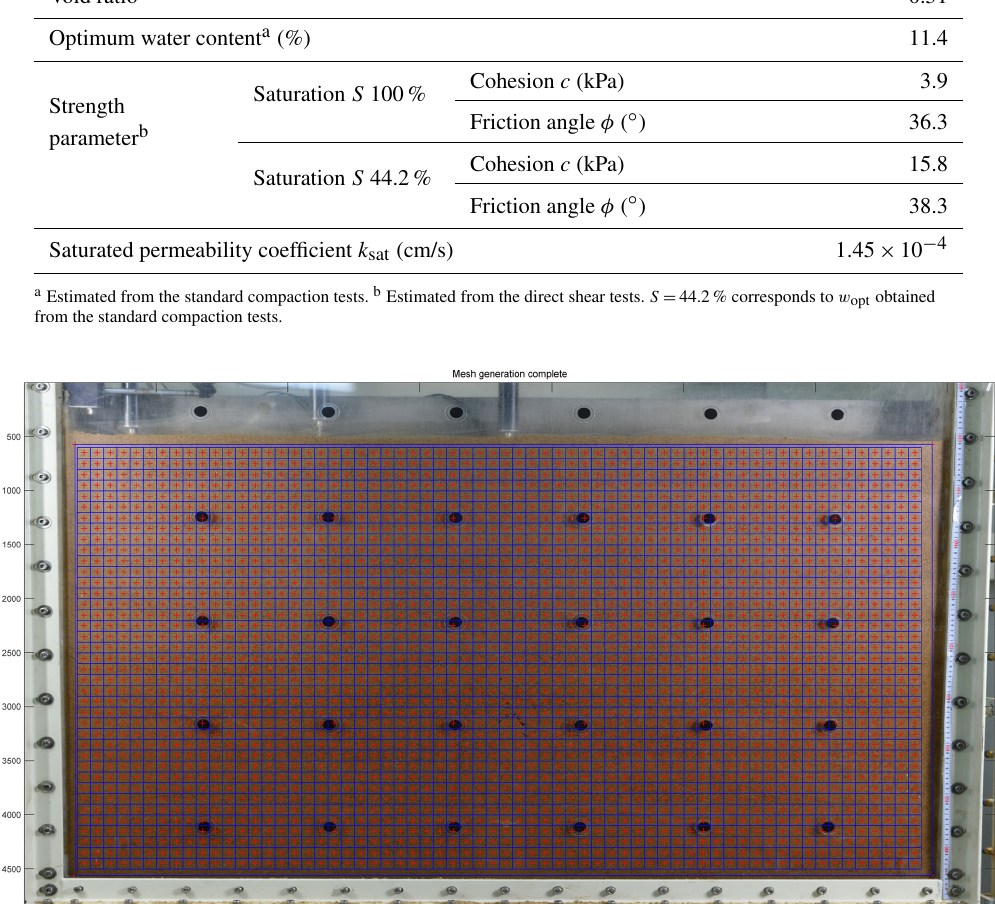
to the positions of a total of 2600 pixel subsets (65 by